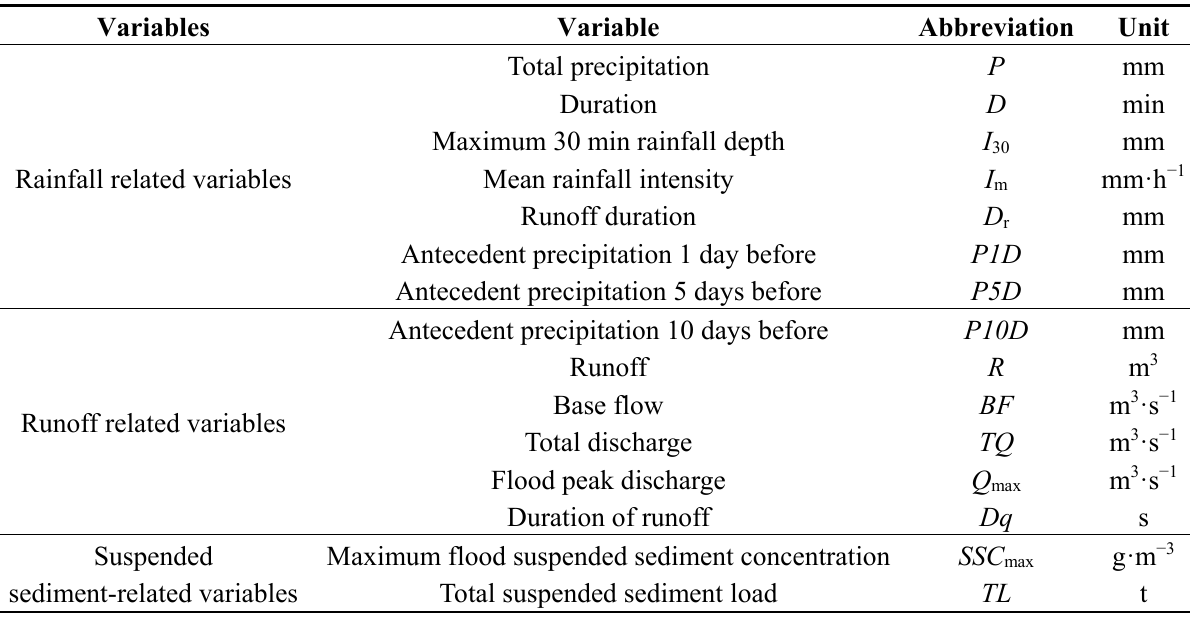
Table 2. Flood variables and associated abbreviations used in the statistical analysis of the relationship between rainfall, runoff, and suspended sediment